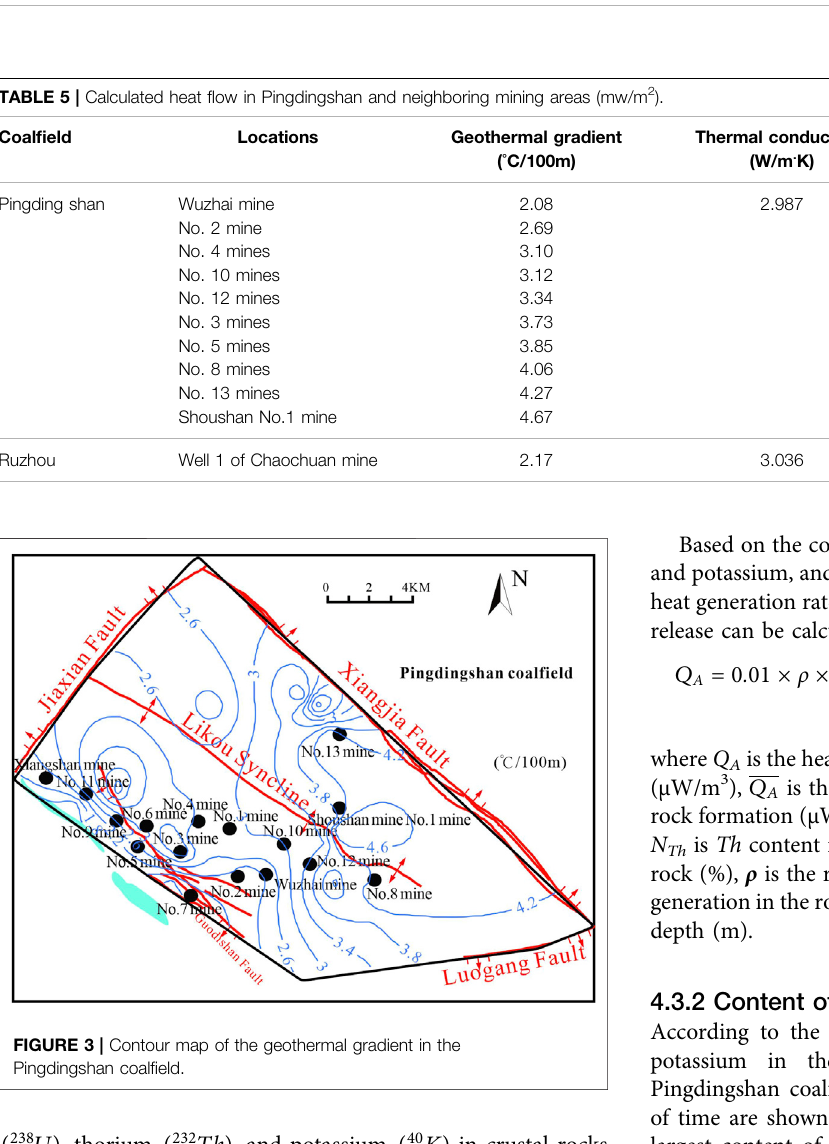
Frontiers in Earth Science |